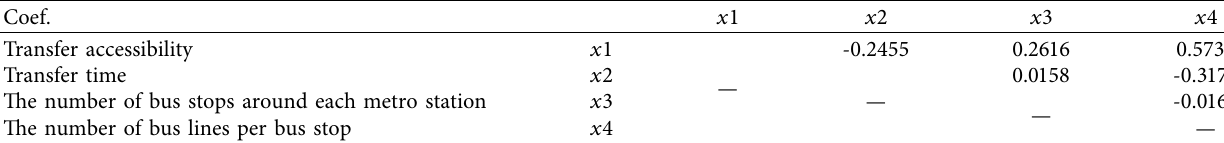
Figure 11: Transfer accessibility of different metro stations. Table 3: The correlation between the independent variables.